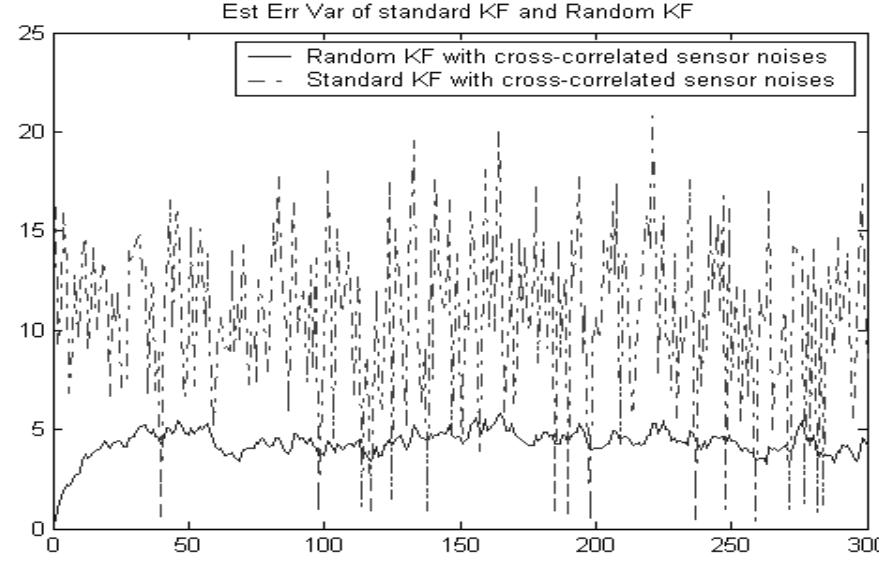
Figure 2. Comparison of standard Kalman filtering fusion and random Kalman filtering